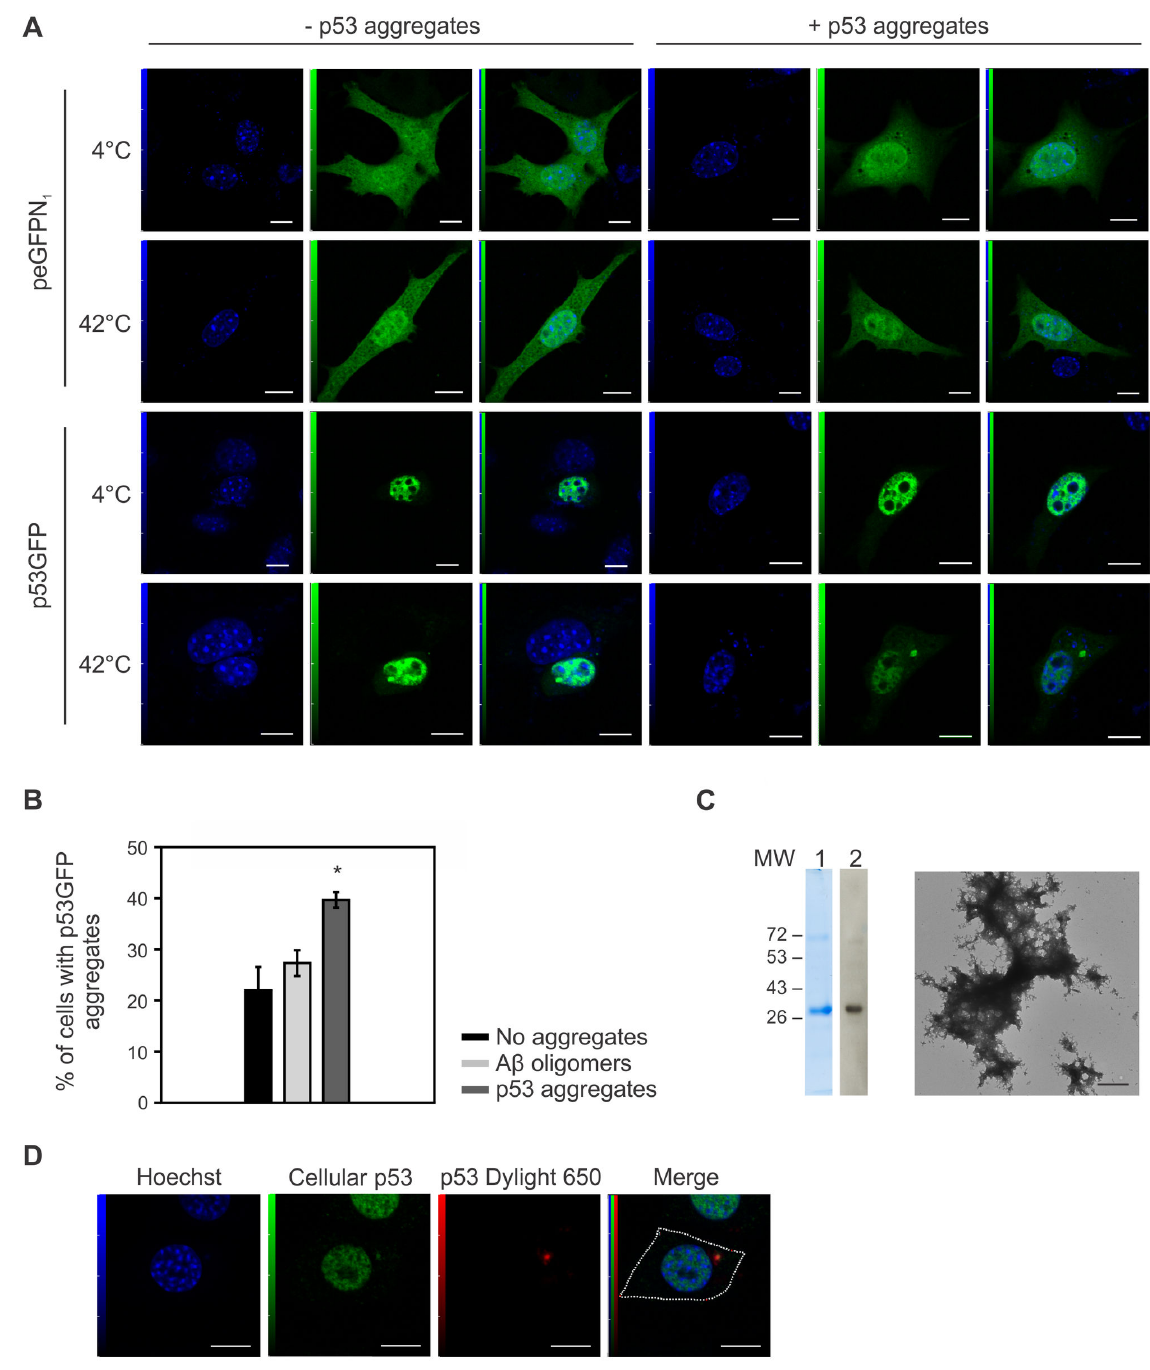
Figure 4. De novo aggregation of soluble p53 with recombinant p53 aggregates. (A) NIH3T3 cells were transfected with p53GFP or pEGFPN1 24 h prior to addition of 1 µM purified p53 protein incubated at 4 °C or 42 °C during 24 h. (B) % of cells containing p53GFP aggregates when incubated with either 1 µM p53 aggregates, Aβ oligomers or without aggregates. Mean value of 3 experiments is shown (*, p < 0,001); 100 cells counted per experiment. (C) Purified p53C protein was resolved by 10% SDS- PAGE and stained with Coomassie Blue (lane 1) or analyzed by Western Blot (lane 2). Transmission electron microscopy showing aggregated p53C. (D) NIH3T3 cells were incubated with 1 µM DyLight 650-conjugated p53C aggregates for 24 h, treated with 0,25% Trypsin/EDTA and re-plated onto microscope slides that were incubated with 100 µM etoposide for 2 h before visualization by confocal microscopy. Scale bars: 5 µm (A), 500 nm (B) and 10 µm (C).